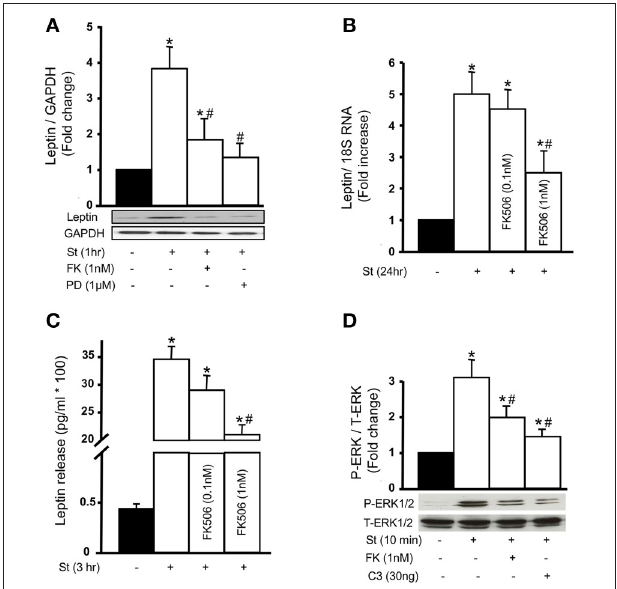
FIGURE 6 | Calcineurin activation promotes mechanical stretch-induced leptin production and release as well as ERK1/2 phosphorylation. (A) Leptin protein expression was evaluated using Western blot densitometric scans and normalized to unstretched RPVs. Pre-treatment with 1nM FK506 (FK) followed by 1h of mechanical stretch significantly decreased leptin protein expression. The ERK1/2 inhibitor PD98059 (1 µ M) also significantly reduced leptin expression in response to 1h of mechanical stretch ( n = 5–6). * p < 0.05 vs. unstretched. # p < 0.05 vs. St 1h. (B,C) Leptin release into the culture medium by VSMCs was measured using immunometric assay while leptin mRNA expression was measured using Real-Time PCR analysis. Mechanical stretch for 24h significantly increased leptin secretion and mRNA expression, while FK506 (FK; 0.1 and 1nM) reduced stretch-mediated leptin release (B) and mRNA expression (C) ( n = 8–9). * p < 0.05 vs. unstretched. # p < 0.05 vs. St 24h. (D) ERK 1/2 phosphorylation (P-ERK1/2) was evaluated by Western blot and normalized to Total-ERK (T-ERK1/2) and to the unstretched RPVs. Mechanical stretch for 10min significantly increased P-ERK1/2 compared to unstretched RPVs. FK506 (1nM) and C3 (30ng/mL) each significantly reduced ERK1/2 phosphorylation in response to 10min of mechanical stretch ( n = 5). * p < 0.05 vs. unstretched. # p < 0.05 vs. St